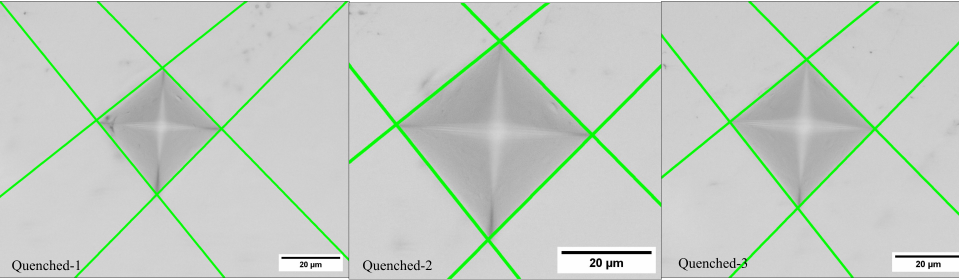
Figure A8. Corner detection on Quenched samples at 10N applied